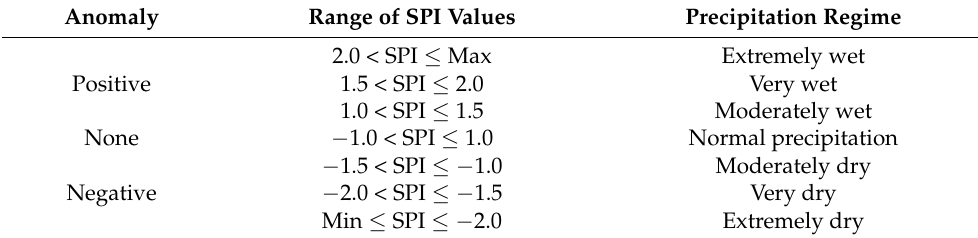
Table 2. SPI classification